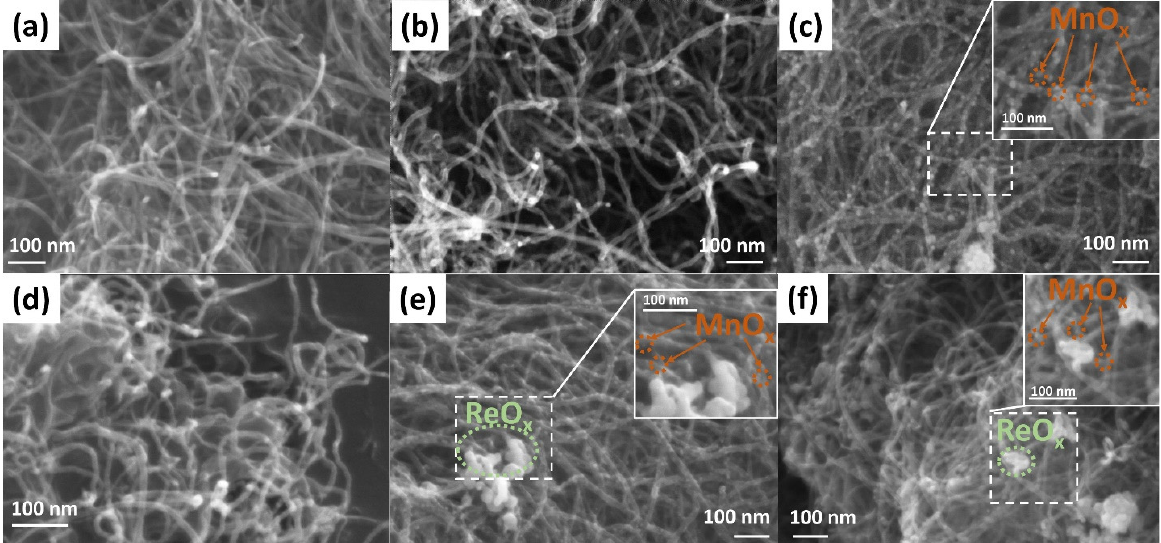
Figure 1. SEM images for ( a ) MWCNTs and composites: ( b ) Mn-0; ( c ) Mn-580; ( d ) Re-360; ( e ) Mn-580 + Re; ( f ) Mn-700 + Re.